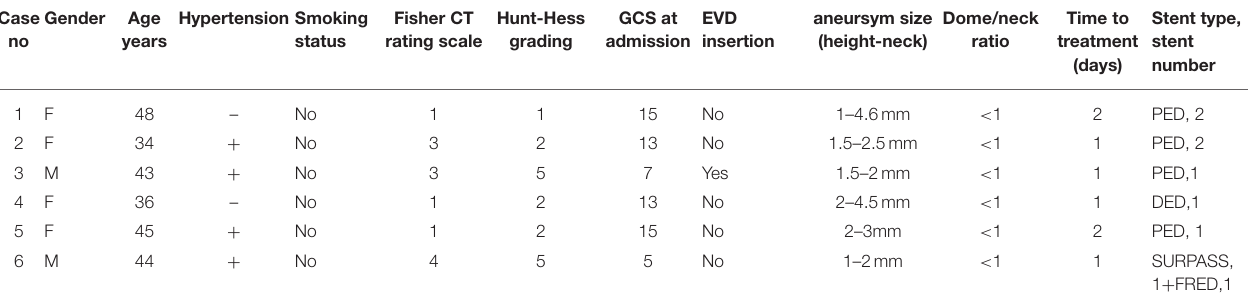
TABLE 1 | Clinical and radiological characteristics of the